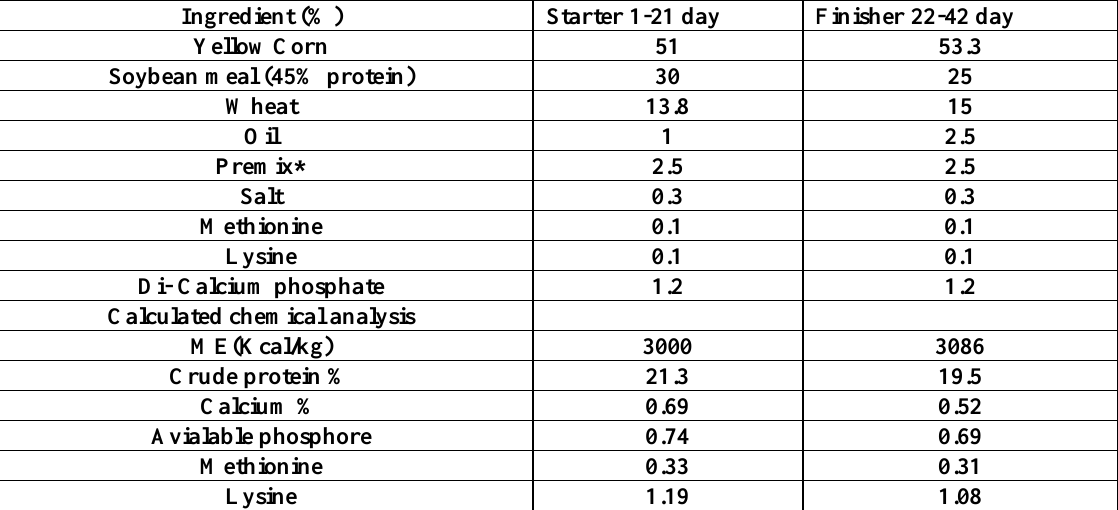
Table (1) The composition of the experimental basal